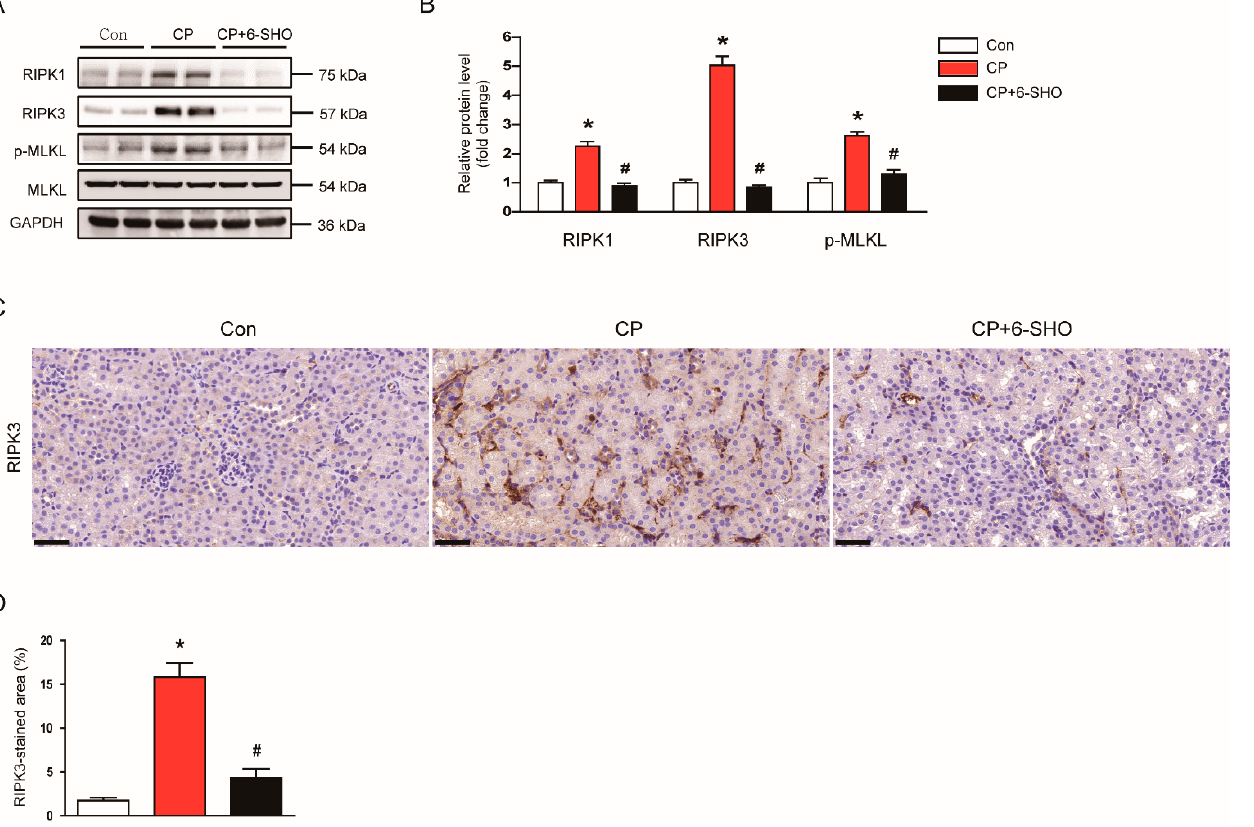
Figure 7. Effect of 6-shogaol on tubular cell necroptosis in cisplatin-treated mice. ( A ) Western blotting of receptor-interacting serine/threonine protein kinase 1 (RIPK1), RIPK3, mixed-lineage kinase domain-like protein (MLKL), and p-MLKL. ( B ) Quantification of western blots for RIPK1, RIPK3, and p-MLKL. GAPDH was used as an internal control. ( C ) Representative images of IHC staining for RIPK3. Scale bar = 40 μ m. ( D ) Quantification of positive staining for RIPK3. n = 8 per group of mice. * p < 0.05 versus Con. # p < 0.05 versus CP.